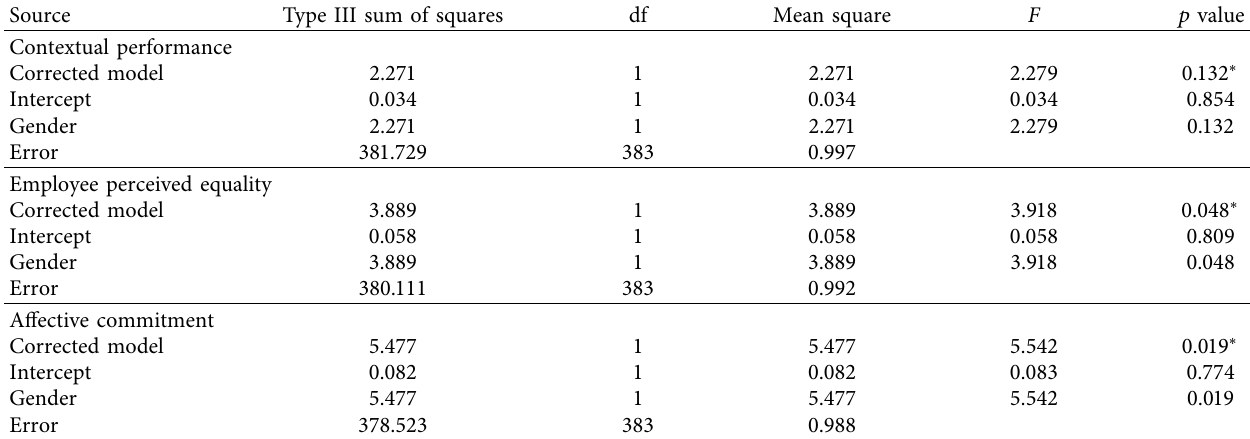
Table 8: Summary results of analysis of variance